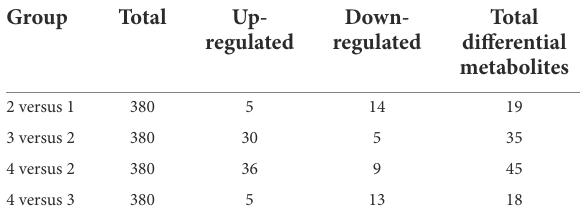
TABLE 4 Differential metabolites between the four tested